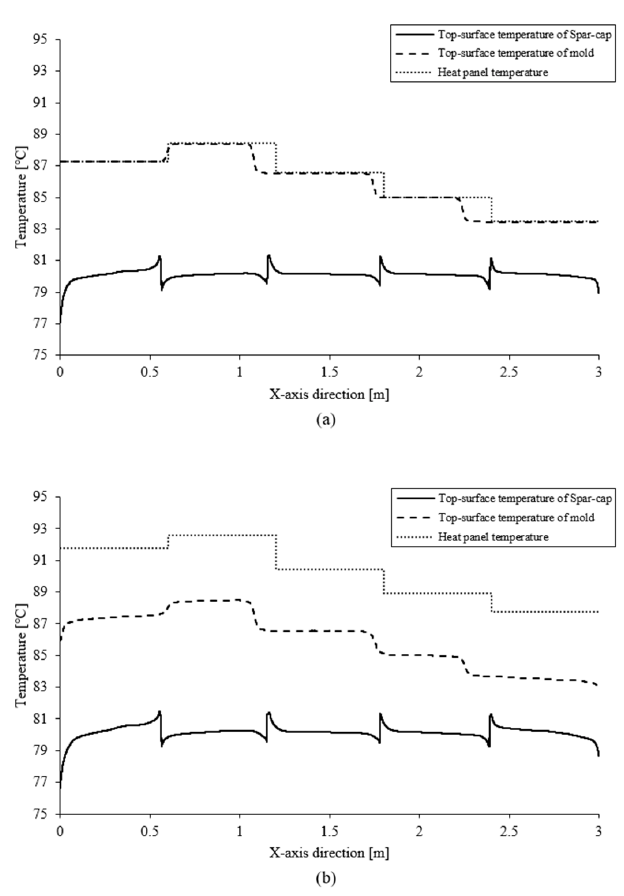
Figure 8. Temperature comparison among mold top surface, spar-cap top surface and heat panel: ( a ) aluminum mold; ( b ) GFRP mold.